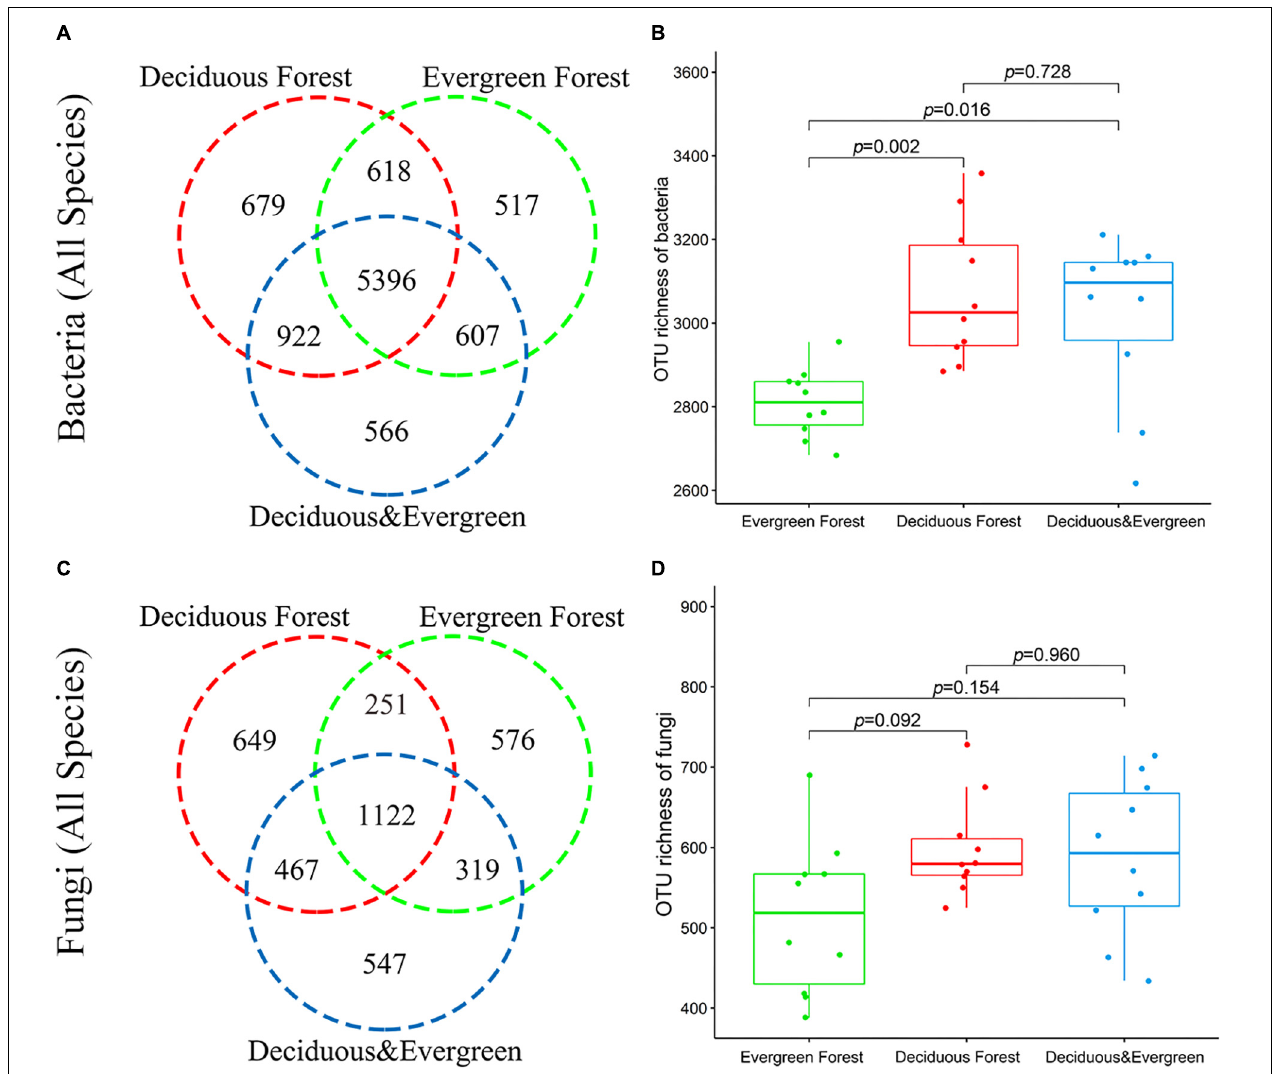
FIGURE 2 | Biodiversity of soil microbes in the temperate urban forest in China. Number of bacterial (A) and fungal (C) OTUs in different vegetation types. OTU richness of bacteria (B) and fungi (D) in different vegetation